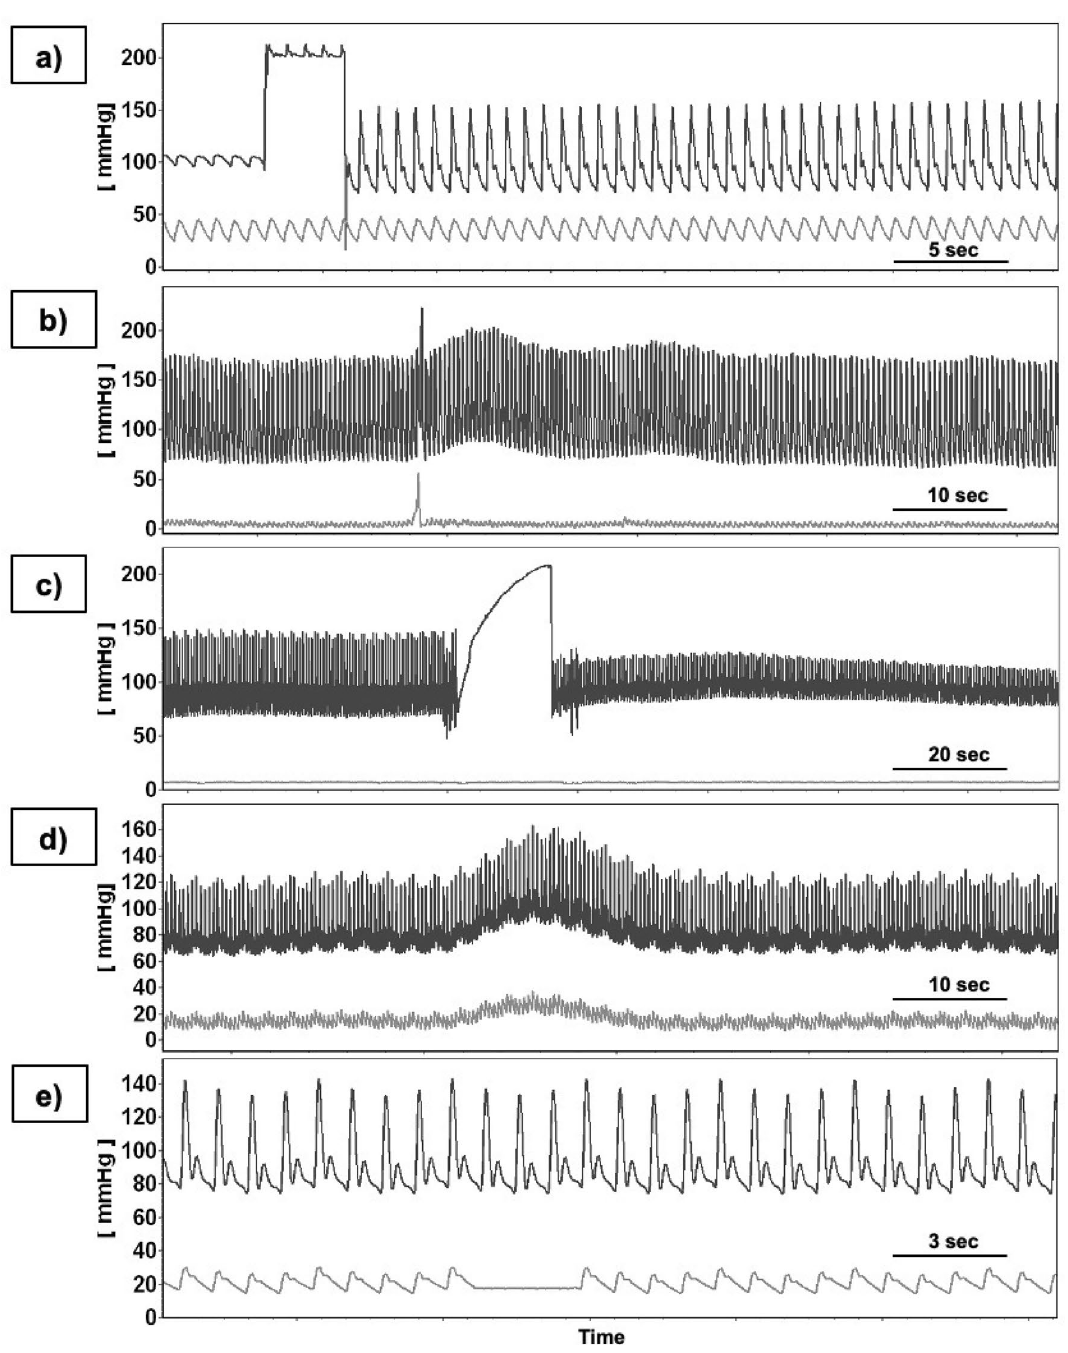
Figure 1. Identified shapes of artifacts: ( a ) rectangular, ( b ) fast impulse, ( c ) saw tooth, ( d ) isoline drift, ( e ) constant